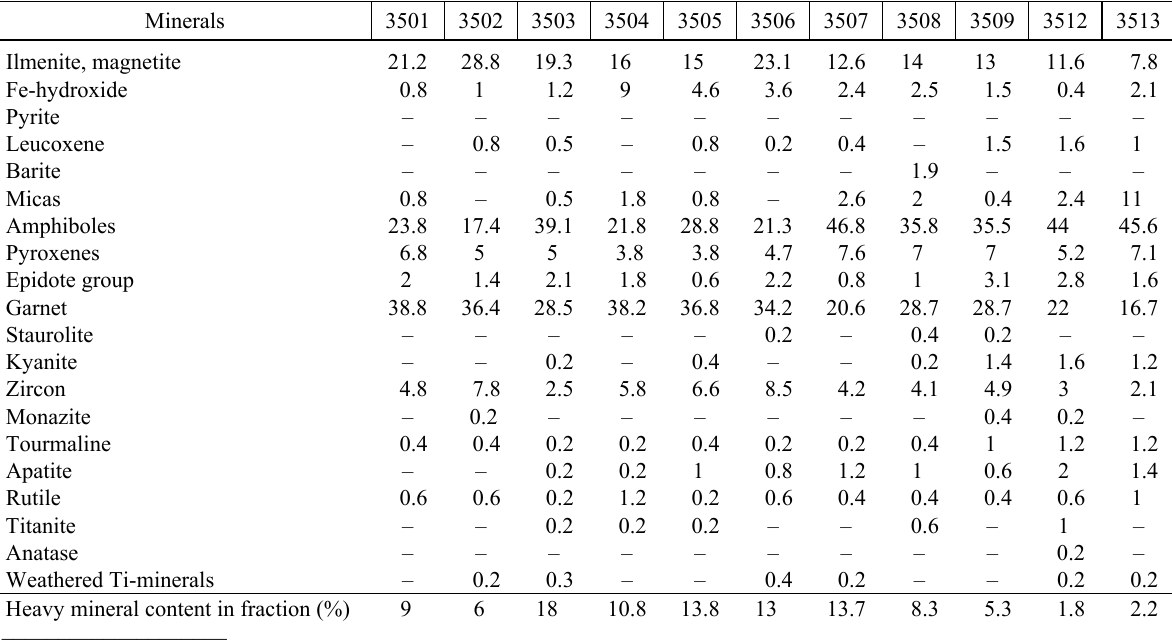
Table 2. Results of optical microscopy analysis of Lemme samples 3501–3509, 3512 and 3513 (grain counts (%), 0.05–0.1